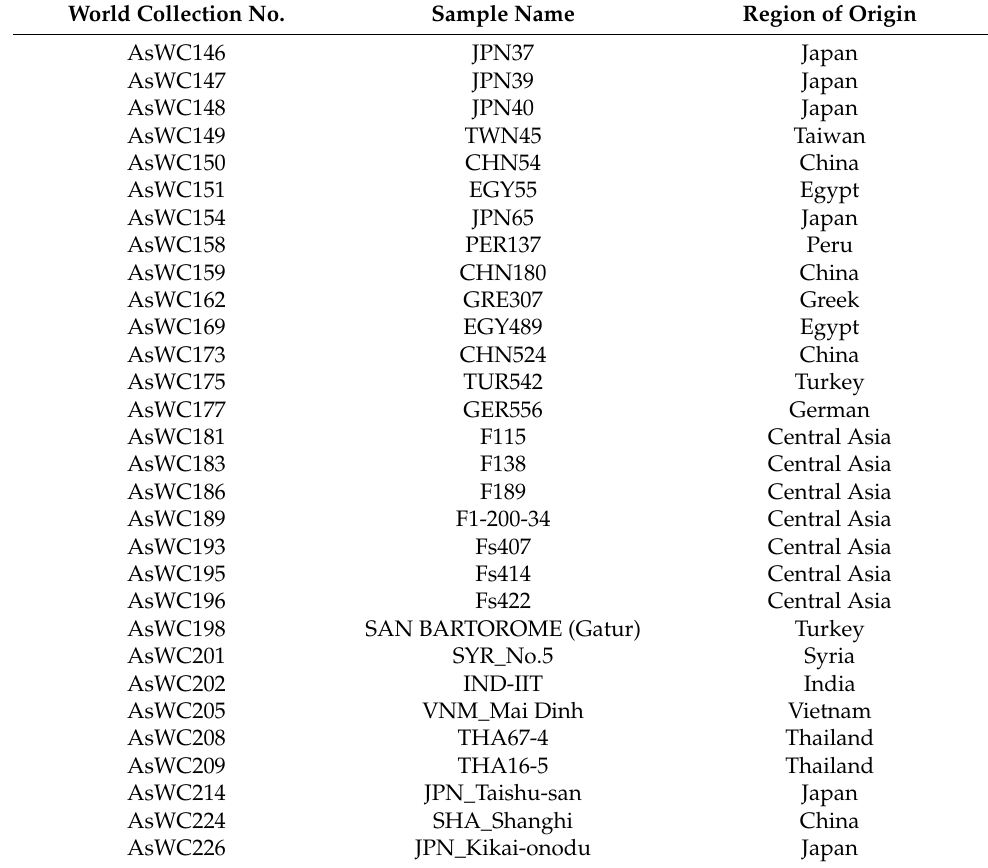
Table 1. Garlic accessions used in the present study. World Collection